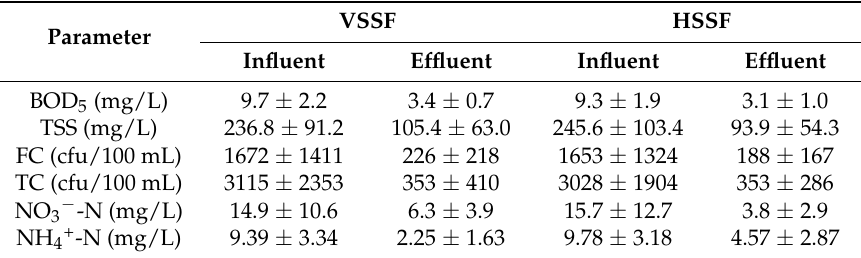
Table 2. Average characteristics of stream water spiked with a nitrogen source at the influents and effluents of VSSF and HSSF wetland